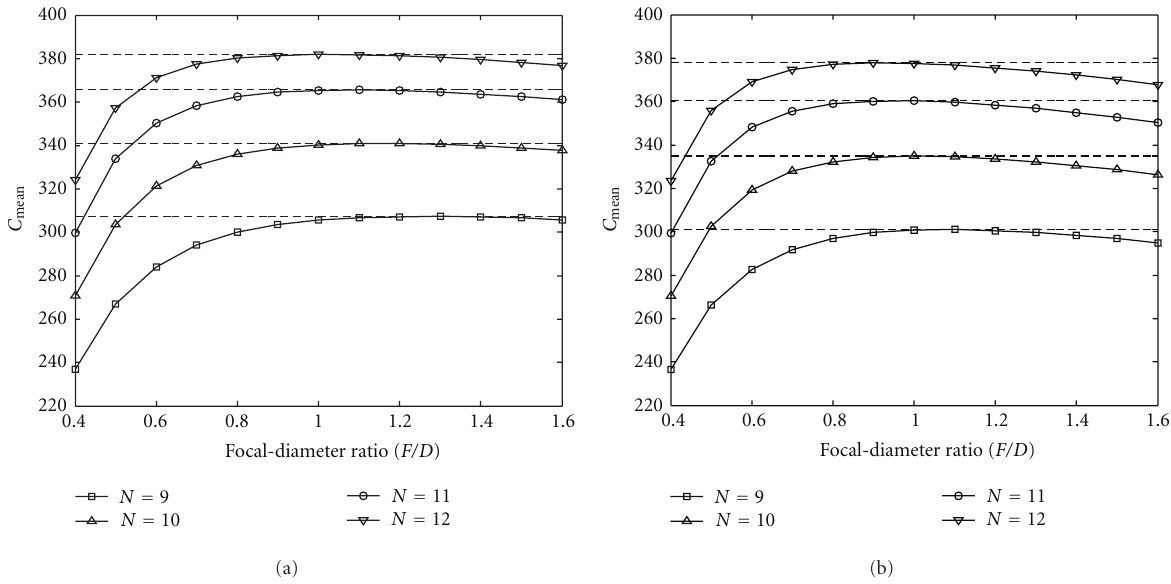
Figure 4: The dependence of the area-weighted mean solar concentration C mean on F/D ratio with the random surface error σ s of (a) 0 mrad and (b) 10